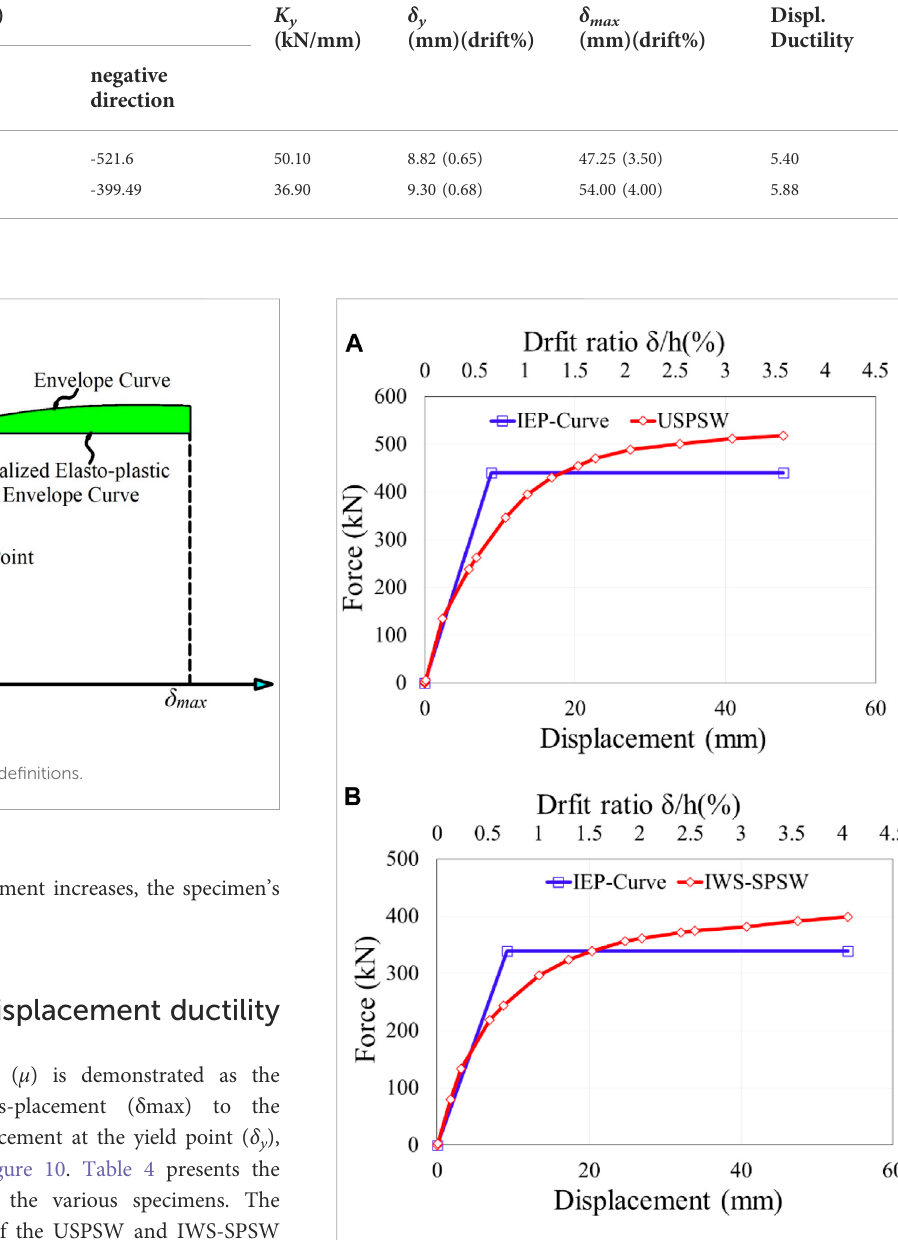
FIGURE 11 The test specimen's envelope and IEP curves: (A) USPSW; (B)